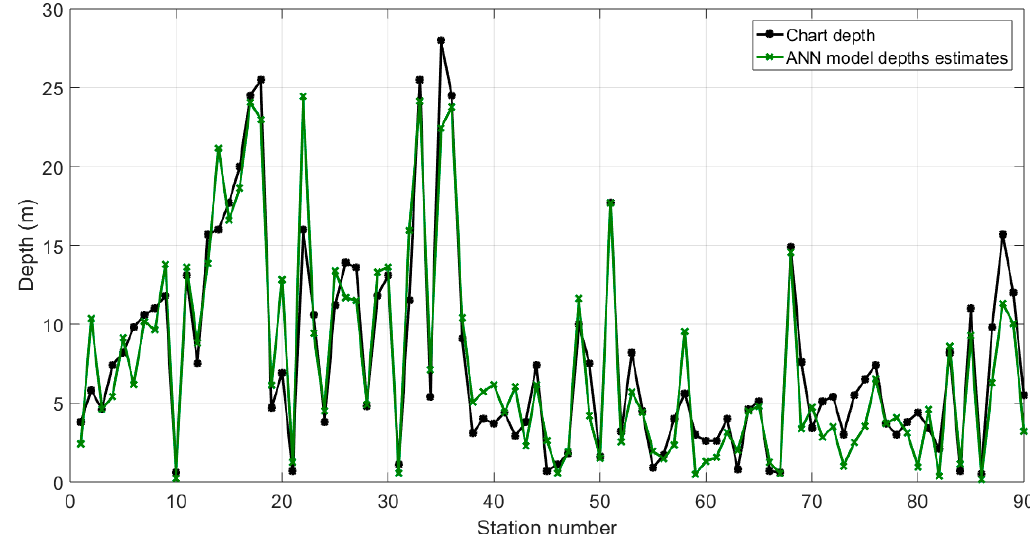
Figure 10. The modelled and validated model depth estimates versus the “truth” nautical chart depths values for the 90 collocated stations using the ANN model.